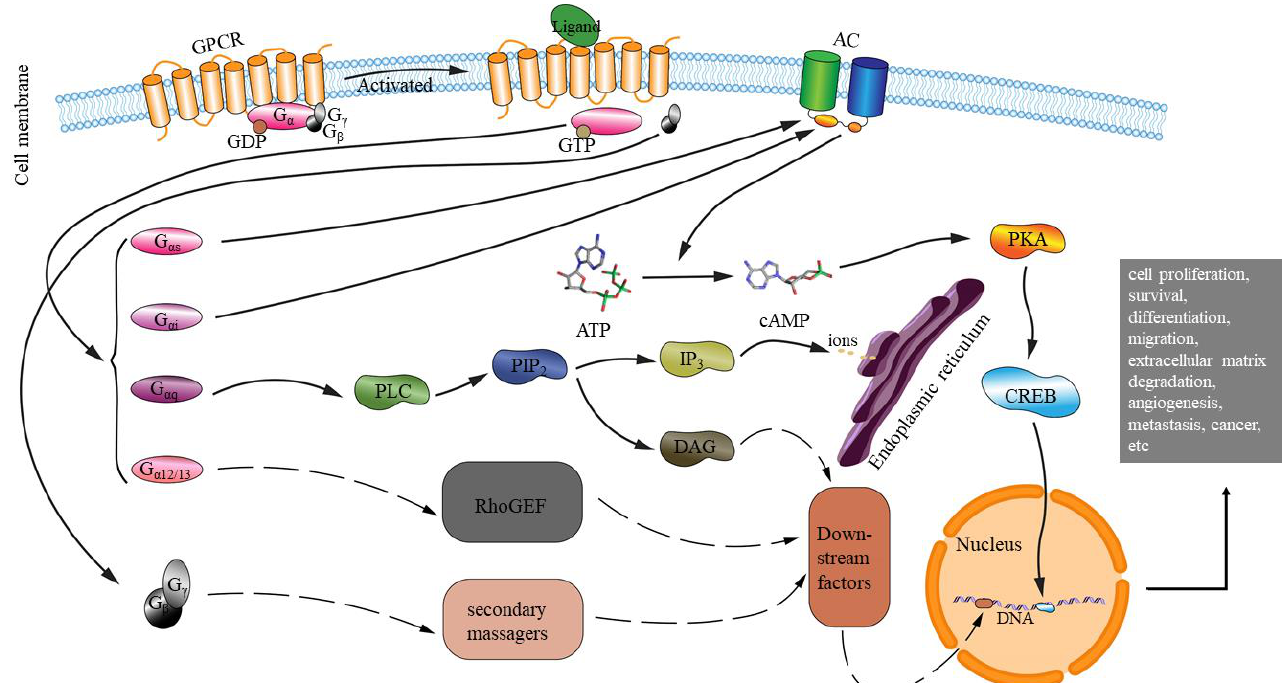
Figure 1. Graphical representation of the locations of GPCR regulatory pathways. GPCRs can be activated by a variety of ligands, interacting with heterotrimeric G-proteins composed of three subunits (Gα, Gβ, and Gγ) [95], and activating several downstream effector molecules [95]. Gα subunits are classified into four subfamilies: Gαs, Gαi, Gαq, and Gα 12/13 [99,100] and can activate adenylyl cyclase (AC) [101], cyclic adenosine monophosphate (cAMP) [102–104], cAMP regulated proteins such as protein kinase A (PKA or cAMP-dependent protein kinase) [105], cyclic nucleotide-gated channels [106], and others [102,104,107], initiating and coordinating intracellular signaling pathways. Gαq can also activate phospholipase C (PLC), which can cleave phosphatidylinositol bisphosphate (PIP 2 ) into diacylglycerol and inositol triphosphate (IP 3 ) and membrane-bound diacylglycerol (DAG) [104,108–110]. IP3 can open the channel on the endoplasmic reticulum membrane [111], and DAG can activate protein kinase C [104,110]. Within the Gα 12/13 family, G-α 13 can increase the activation of p115RhoGEF (the Rho guanine nucleotide exchange factor) and related RhoGEF proteins linked to the Rho activation [112]. Several proteins are known to interact with Gα 12 , including Btk-family tyrosine kinase, Ras GTPase activating protein, cadherins, p120-caterin, and others [95,104,113–117]. Gβγ subunits can also send signals to phospholipase C, voltage gated Ca 2+ channels, and others.